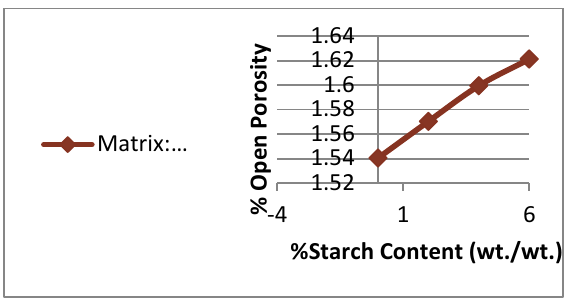
Figure, 6: Open porosity of (Acrylic bone cement: 15 % PMMA: % X starch) as a function of starch material content in blend.